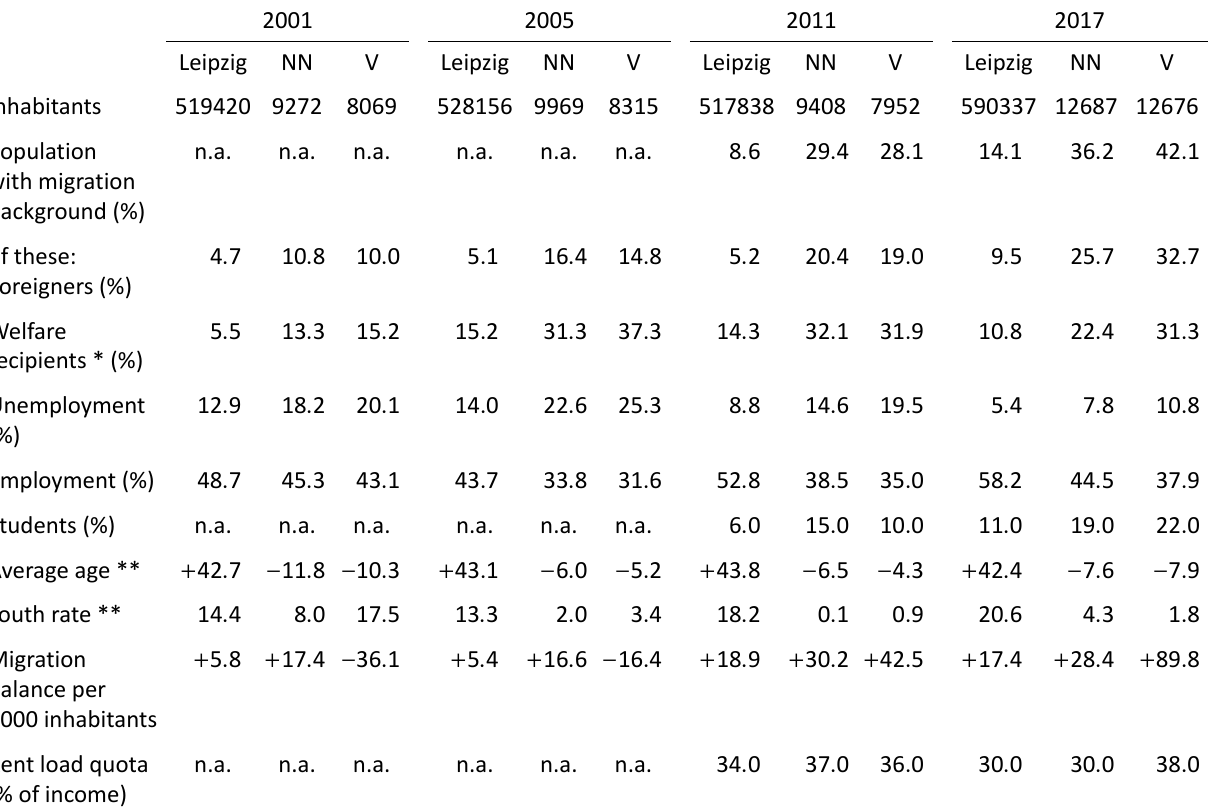
Table 2. Selected socio-demographic and socio-economic data for Leipzig and the districts NN and V for the period